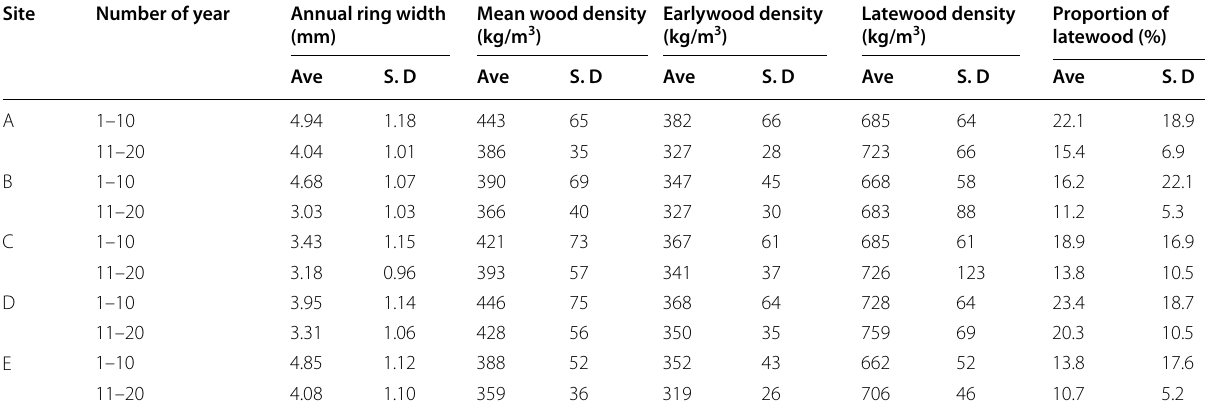
Ave. and S. D. represent average and standard deviation, respectively